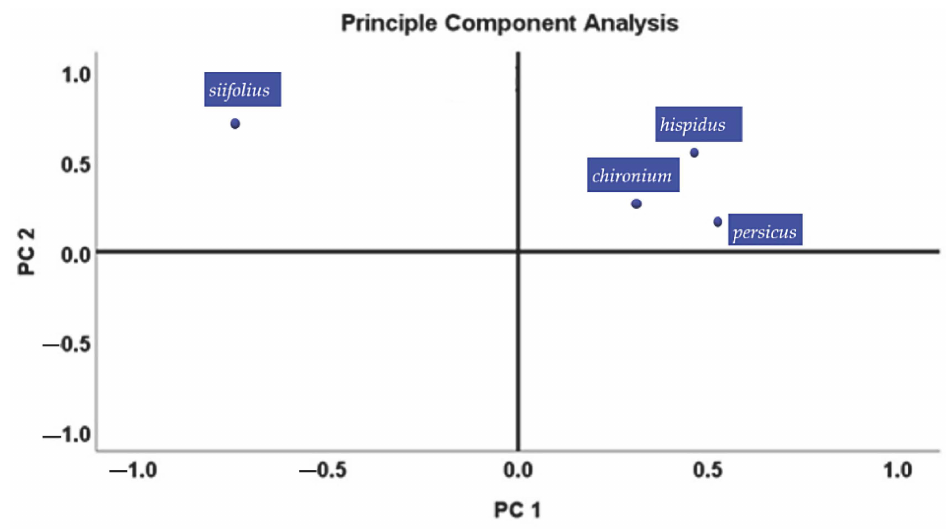
Figure 2. The composition of the essential oils of Opoponax species was analyzed using principal component analysis